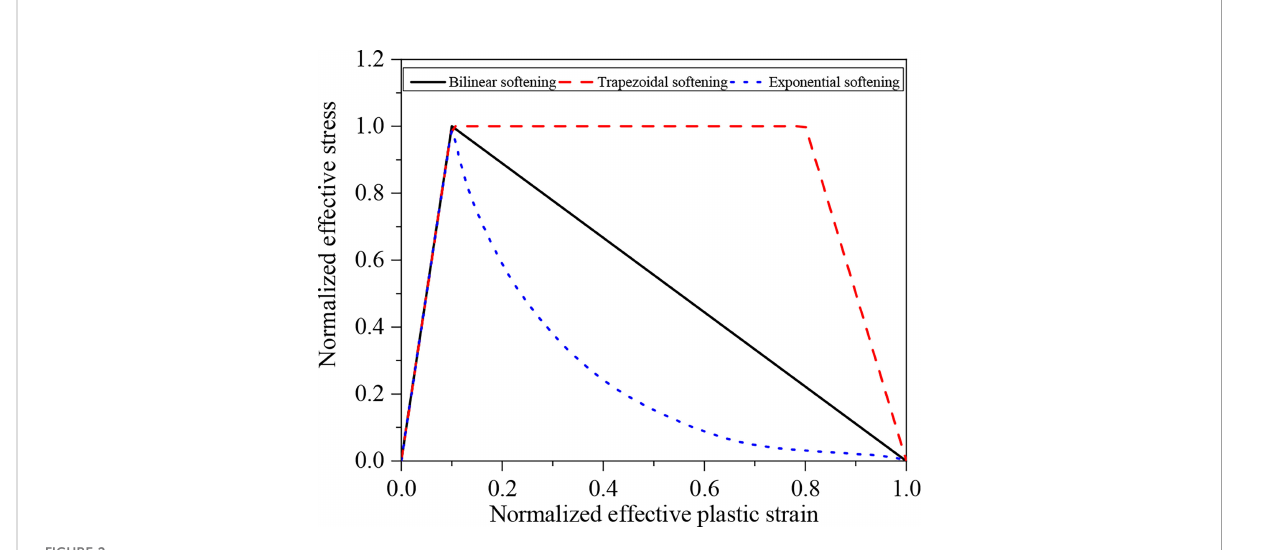
FIGURE 2 Cohesive element failure criterion models.